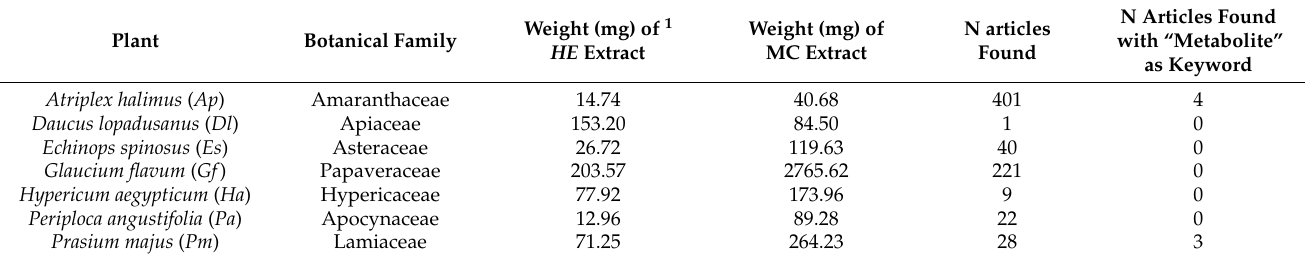
Table 1. Name, yields of organic extracts and relevant bibliography for seven native plants collected in